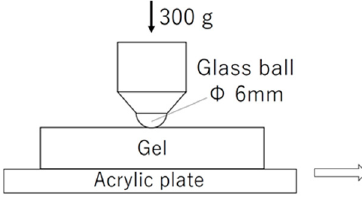
Figure 2. Schematic illustration of experimental set-up of friction measurements. The lower plate was moved during the measurements.